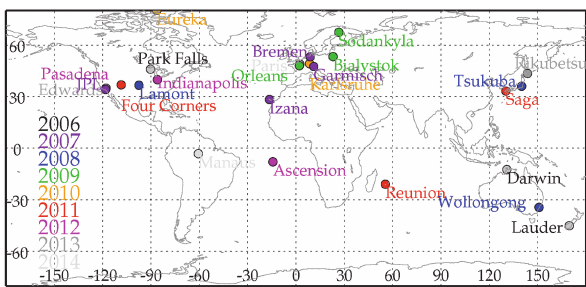
Figure 1. TCCON site locations used for this work. The color indi- cates the year when each station started collecting